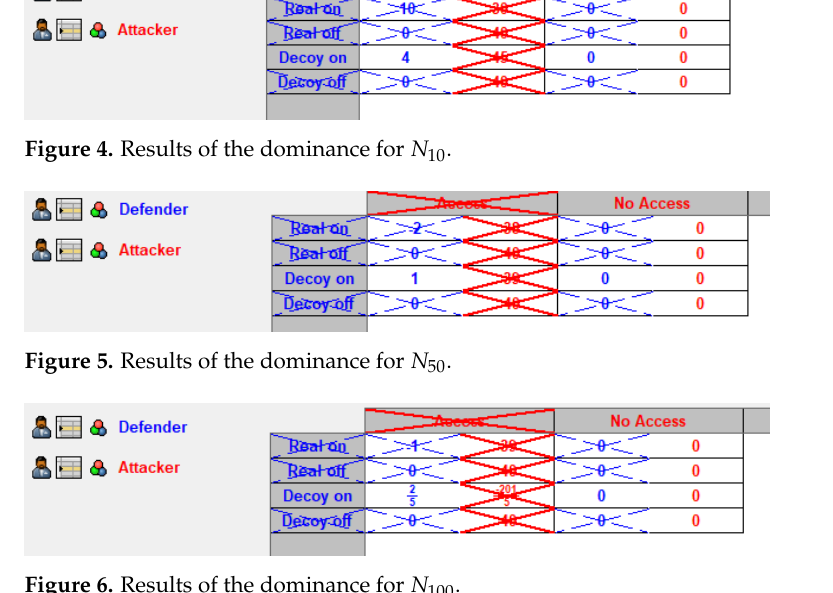
Figure 6. Results of the dominance for N 100 .